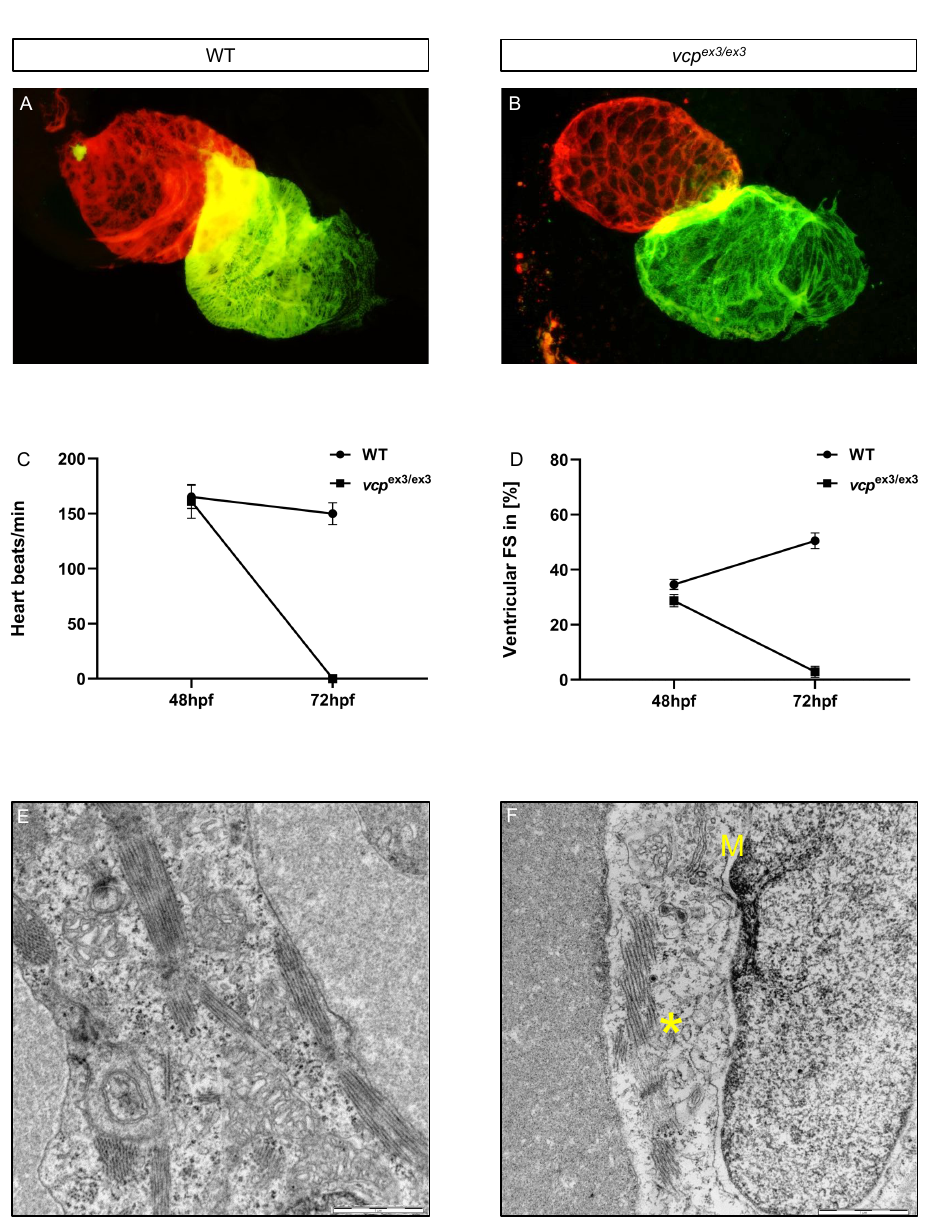
Figure 3. Genetic loss of vcp leads to heart failure in homozygous mutant embryos. ( A , B ) Analysis of the distribution of meromysin (MF20, green) and atrial-specific myosin heavy chain (S46, red) shows normal expression levels and patterns in vcp ex3/ex3 embryos, suggesting regular heart chamber specification and cardiomyocyte differentiation. ( C ) Heart rate quantification at 48 hpf does not reveal any alterations in vcp ex3/ex3 embryos (161 ± 15 heart beat/min) compared to age-matched clutchmates (165 ± 10 heart beat/min) (N = 3, n = 11/12, mean ± S.D, p = 0.7000 determined using two-tailed t -test). At 72 hpf, vcp ex3/ex3 embryos show highly significant reduction in the heart rate (N = 3, n = 9/12; vcp ex3/ex3 0 heart beat/min; WT 150 ± 10 beats/min; mean ± S.D p ≤ 0.0001; two-tailed t -test). ( D ) Measurement of ventricular fractional shortening at 48 hpf shows no significant differences between WT (34.64 ± 8%) and vcp ex3/ex3 (28.73 ± 7%) embryos (N = 3, n = 19/9, mean ± S.D; p = 0.1000; two-tailed t -test). At 72 hpf, fractional shortening is significantly reduced in vcp ex3/ex3 embryos (N = 3, n = 12, mean ± S.D; FS vcp ex3/ex3 3 ± 7%; FS WT 50.48 ± 10%; p ≤ 0.0002; two-tailed t -test). ( E , F ) Electron microscopic pictures of WT and vcp ex3/ex3 hearts at 72 hpf. vcp ex3/ex3 embryos show severely dysmorphic mitochondria (M) and disorganized myofibrils (*). ns: not